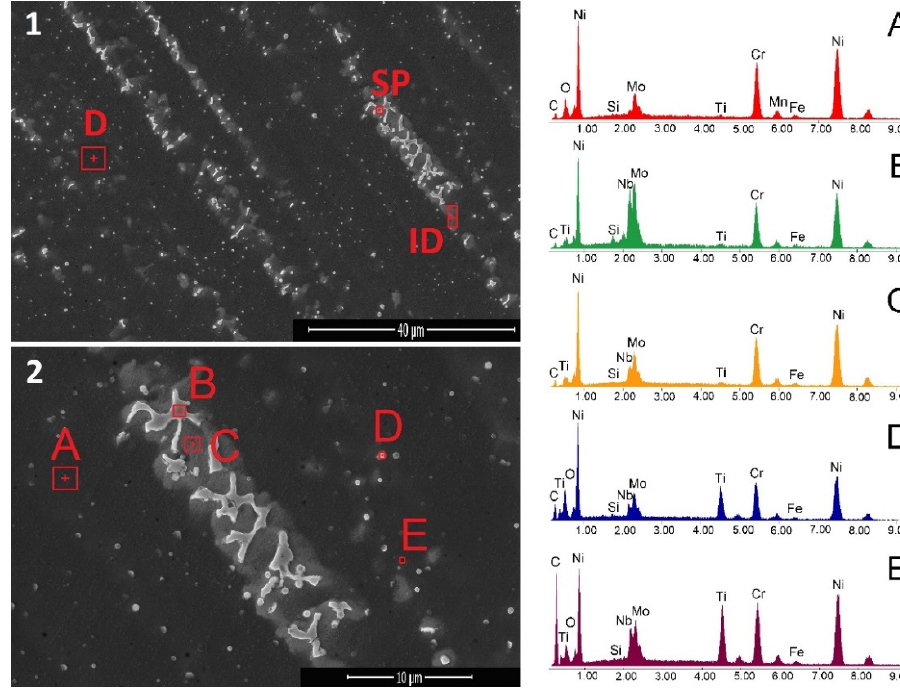
Figure 3. Representative SEM images of cross section NiCr laser-cladded coating with Ti addition at low ( 1 ) and high magnification ( 2 ) with EDS spectrum of different phases ( A – E ).